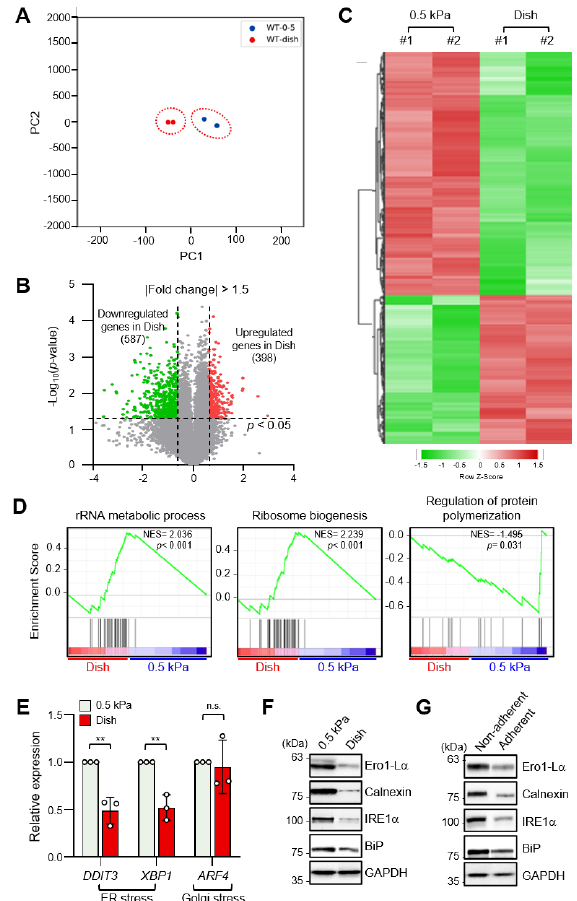
Figure 1. Endoplasmic reticulum (ER) stress is differentially regulated by extracellular matrix (ECM) stiffness. ( A ) Principal component analysis (PCA) of the RNA-sequencing (RNA-seq) datasets obtained from MDA-MB-231 cells cultured on soft and stiff matrices. ( B ) Volcano plot of differentially expressed genes (DEGs) in MDA-MB-231 cells according to ECM stiffness based on RNA-seq results. Genes with significantly decreased expression are shown in green; genes with significantly increased expression are shown in red. ( C ) Heatmap of all DEGs between cells cultured on soft matrix and stiff matrix. ( D ) Gene set enrichment analysis (GSEA) of ECM stiffness-dependent signaling pathways. ( E ) Expression of ER stress and Golgi stress markers in MDA-MB-231 cells cultured on 0.5 kPa polyacrylamide gels (PAGs) or culture dishes was quantified by RT-qPCR. Values represent the mean ± SD of three independent experiments and were analyzed using Student’s t -test. ** p < 0.01, N.S. not significant. ( F ) MDA-MB-231 cells were cultured on 0.5 kPa PAGs or dishes for 48 h. Cell lysates were used for Western blotting analysis of the ER stress markers Ero1-L α , Calnexin (CANX), IRE1 α , and BiP. ( G ) MDA-MB-231 cells were cultured on non-adherent or adherent plates for 48 h. Cell lysates were used for Western blotting analysis of the ER stress markers Ero1-L α , Calnexin, IRE1 α , and BiP. GAPDH was analyzed as a loading control in all Western blot